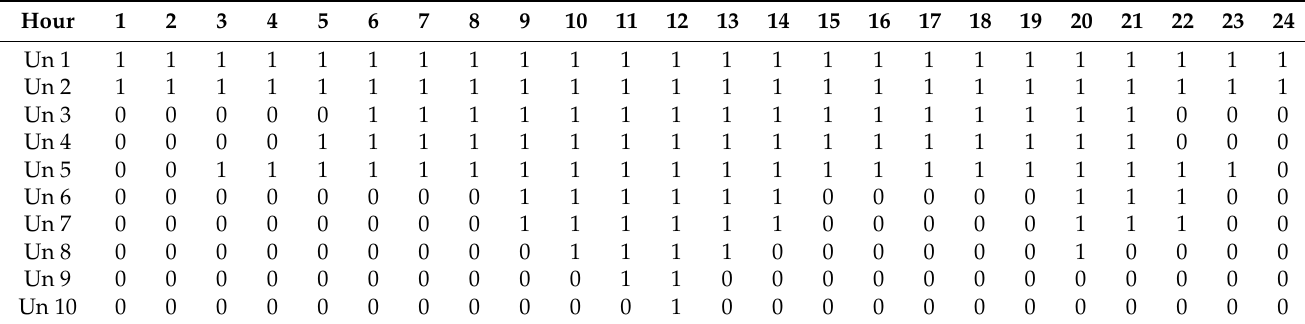
Table 5. Optimal scheduled operation for the 10-unit system over 24 h (test system 1).